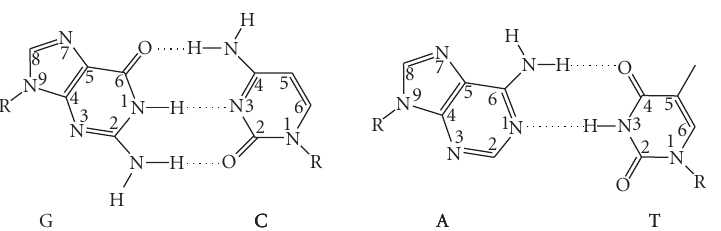
Figure 2: The canonical Watson-Crick base pairs. Standard numbering is indicated. Unless otherwise noted, R indicates the position of the deoxyribose in all